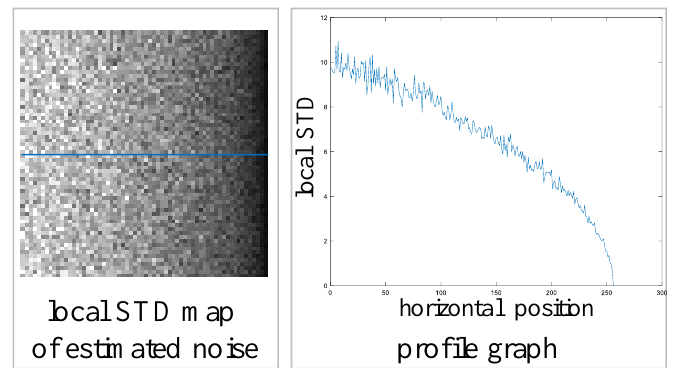
Figure 4. Spatial variation of local standard deviation (STD) of the estimated noise.